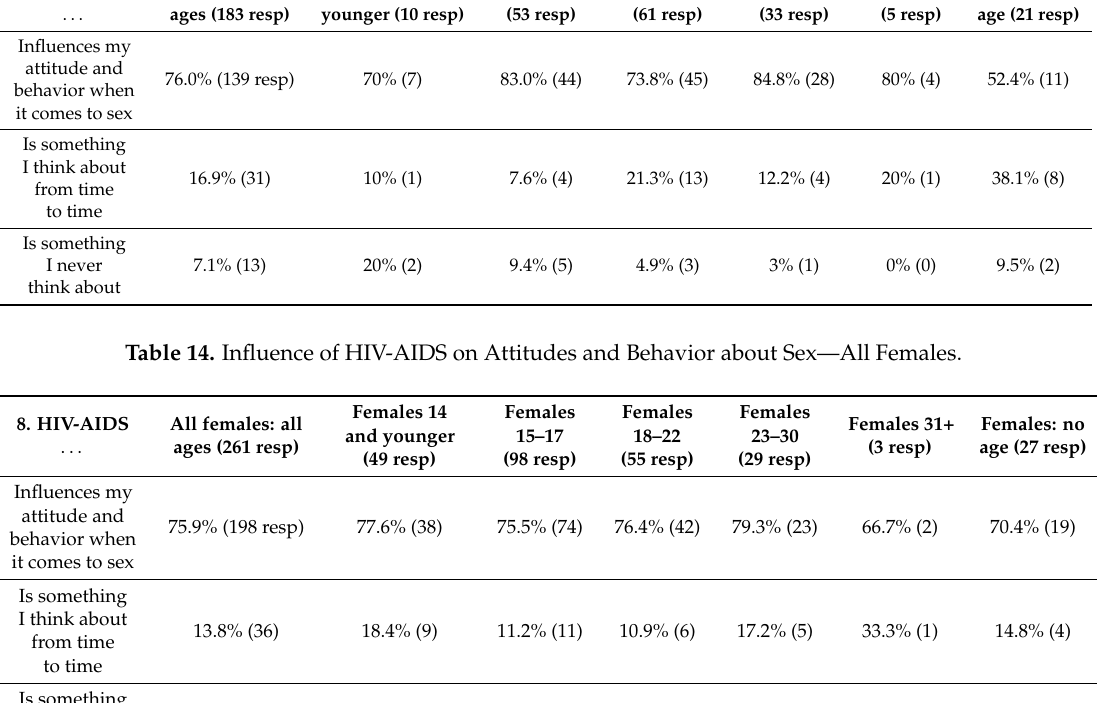
Table 13. Influence of HIV-AIDS on Attitudes and Behavior About Sex—All Males. 8. HIV-AIDS ...